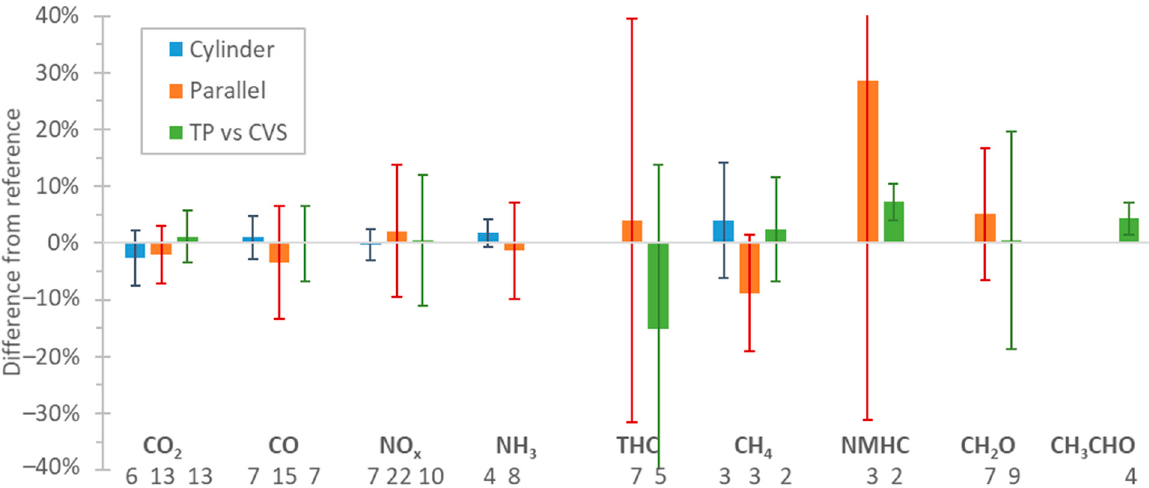
Figure 4. Overview of FTIR assessment studies. For each component, the mean deviations from the reference instruments were calculated based on the studies of Appendix A. “Cylinder” refers to calibration gases. “Parallel” means FTIR and reference instruments were measuring both from the dilution tunnel or the tailpipe. “TP vs. CVS” refers to cases where the FTIR was measuring from the tailpipe, while the reference instrument from the dilution tunnel. Error bars show one standard deviation of at least two studies. Numbers give the number of studies for the calculation of the means.